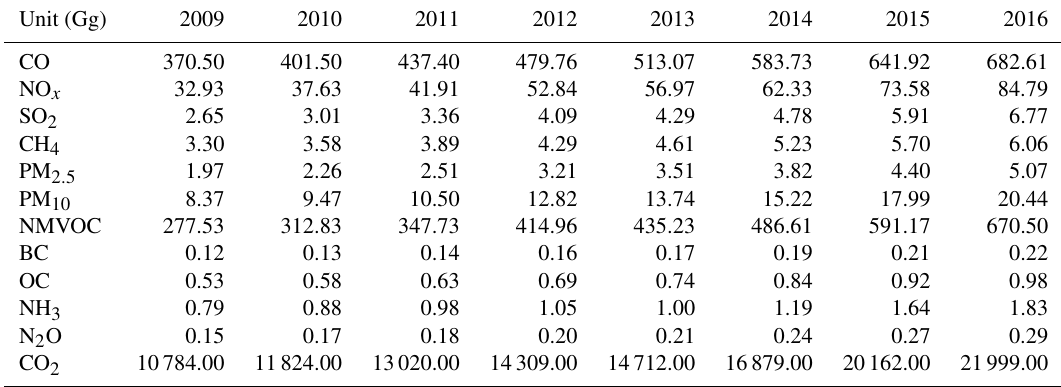
Table 10. Annual emissions for each species from the transportation sector in HCMC from 2009 to 2016 (Ggyr − 1 ). Unit